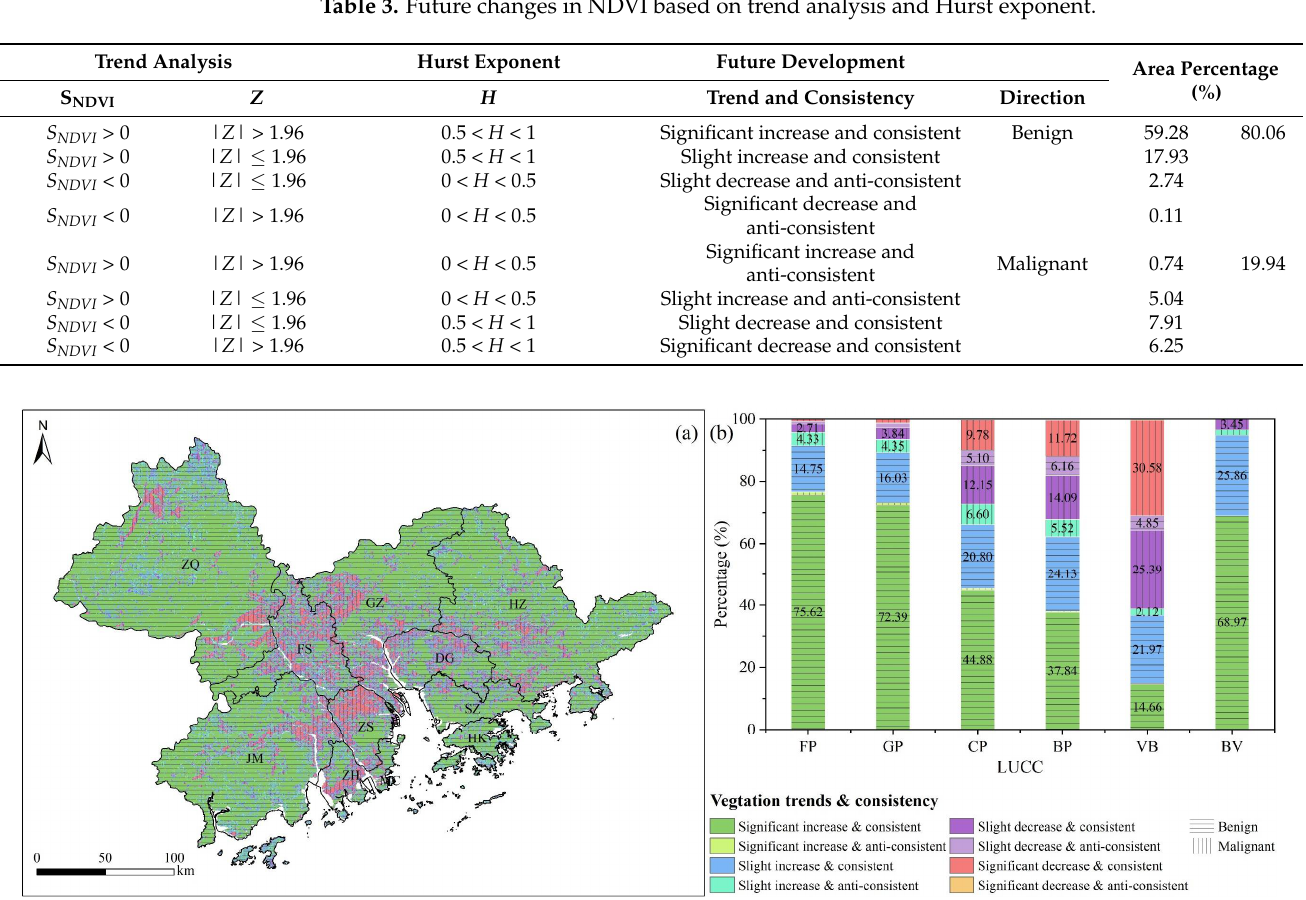
Figure 4. Future trends of NDVI in the GBA. ( a ) Spatial pattern of NDVI trend and future con- sistency; ( b ) area percentage of NDVI future trends for main LUCC types. FP—forest persistence; GP—grassland persistence; CP—cropland persistence; BP—built-up persistence; VB—vegetation to built-up; BV—built-up to vegetation.